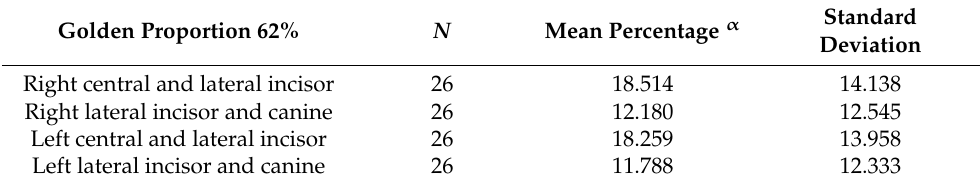
Table 4. Mean values of golden proportion found in included articles ( n =